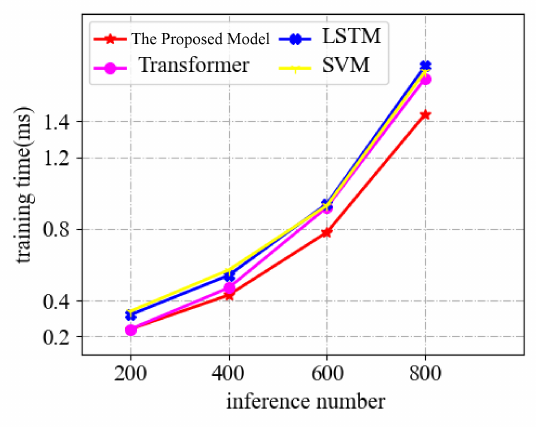
Figure 6. Comparison of efficiently training time of different